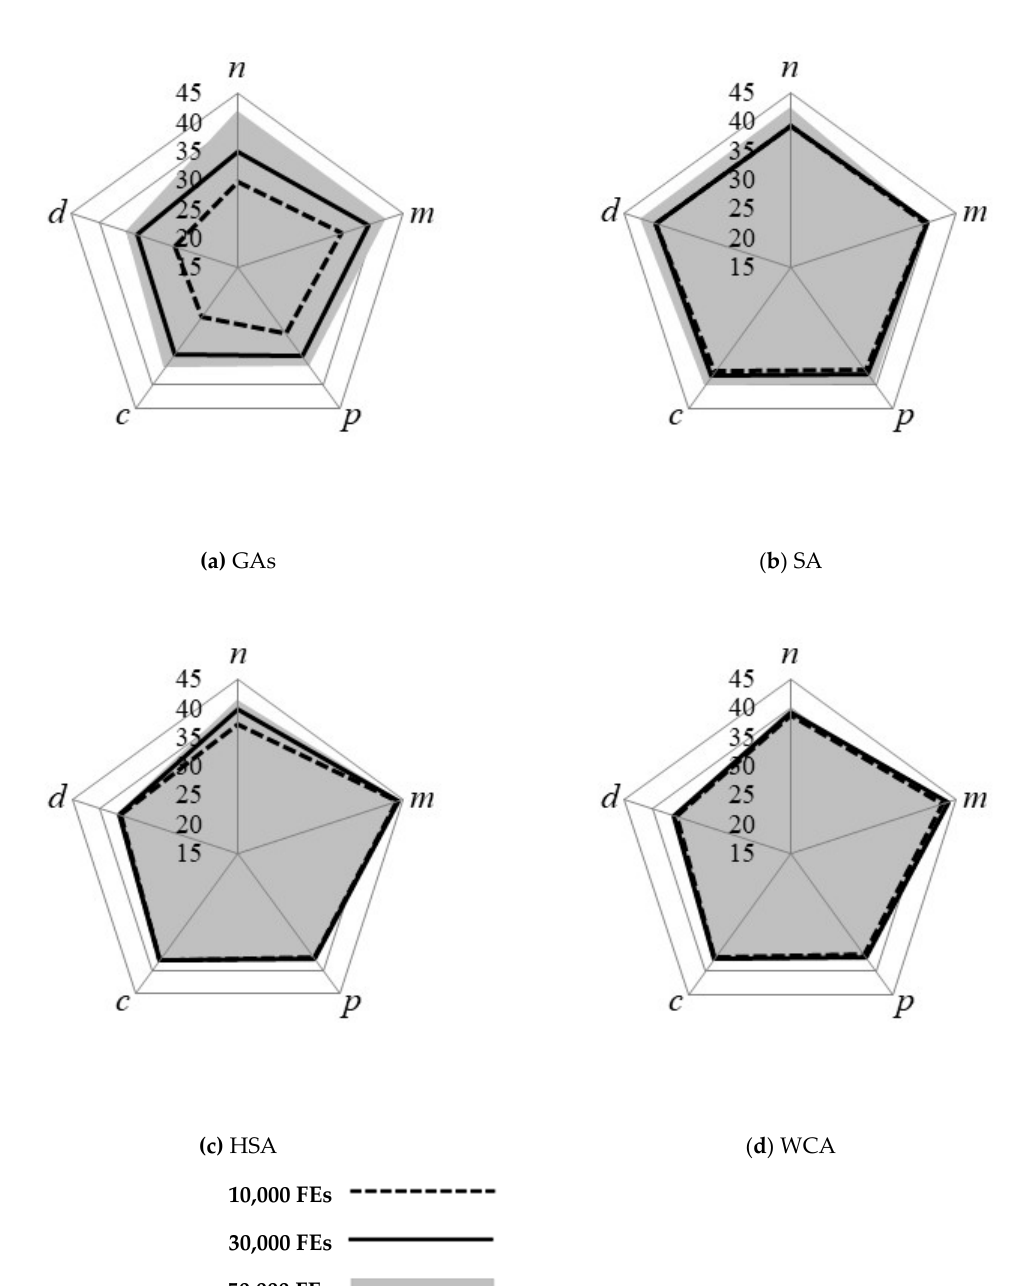
Figure 5. Performance comparison results (mean of best improvement ratio in percentage). ( a ) GAs; ( b ) SA; ( c ) HSA; and ( d ) WCA.